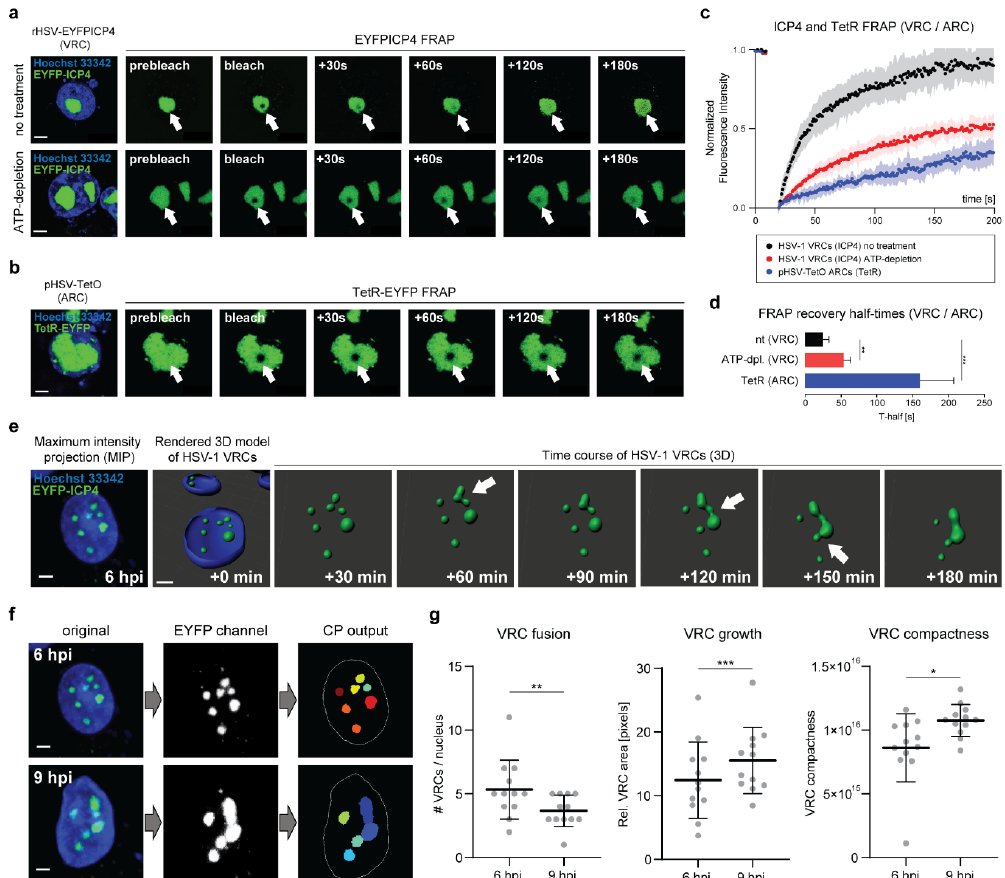
Figure 4. ICP4 retains its liquid-like properties in HSV-1 VRCs. ( a ) ICP4 exhibits rapid diffusion kinetics within HSV-1 VRCs. Vero cells were infected with rHSV-EYFPICP4 at a multiplicity of infection (MOI) of 1. At 12 hpi, the cells were counterstained with Hoechst 33342 and processed for FRAP using CLSM (SP8 Falcon, Leica). A circular area of 1 µm in diameter was bleached within the HSV-1 VRC using 10 iterations of 100% laser power. The bleached area was then monitored for 3 min and an image was captured every second (see also Movie S4). ATP depletion was performed at 10 hpi for 2 h and FRAP was performed as described above (see also Movie S5). Scale bars: 5 µm. ( b ) FRAP kinetics of HSV-1 amplicon DNA within amplicon replication compartments (ARCs). Vero cells were transfected with 0.5 µg of pHSV-TetO and 0.01 µg of pSV2-EYFP-TetR. At 16 hpt, the cells were infected with wt HSV-1 at a MOI of 2. FRAP experiments were performed at 12 hpi and analyzed as described in panel (4a) (see also Movie S6). ( c ) Quantification of the FRAP experiments. For FRAP analysis, 6–12 individual VRCs were used. The raw FRAP data were normalized with easyFRAP and analyzed with Prism (GraphPad). The normalized fluorescence intensity is plotted over time (s). ( d ) ICP4 recovery half-times (T-half) were evaluated with the FRAP data from panel (4c) using easyFRAP. Bar plots represent mean values with SDs. Statistical significance was determined using a Welch’s t -test; p < 0.005 (**) and p < 0.0005 (***). ( e ) 3D live-cell imaging of Vero cells infected with rHSV-EYFPICP4 (MOI 1). At 6 hpi, the nuclei were counterstained with Hoechst 33342 and processed for live imaging with a spinning disk confocal laser scanning microscope (CLSM). Z-stacks of the specimen were taken every 10 min for 3 h. A representative z-stack of an infected nucleus at 6 hpi is shown as a maximum-intensity projection (MIP) (left) and used for time-course 3D imaging using the Imaris software (Bitplane). Fusion events during the course of infection are indicated with white arrows. Images were taken from Movie S7 every 30 min; Scale bar: 5 µm. ( f ) Cell Profiler (CP) processing procedure for the quantification of the HSV-1 VRC phase behavior. MIP images of the representative cell nucleus from panel (4e) are shown as an example at 6 and 9 hpi. Scale bar: 5 µm. ( g ) Quantification of the HSV-1 VRCs phase behavior. A total of 12 infected cell nuclei were processed using the customized CP pipeline from panel ( f ). The number of VRCs per nucleus, the relative VRC size, and compactness were assessed at 6 and 9 hpi for each candidate nucleus. Horizontal bars represent mean values with error bars showing SD values. Statistical significance was determined with a Welch’s t -test; p < 0.05 (*), p < 0.005 (**), and p < 0.0005 (***).